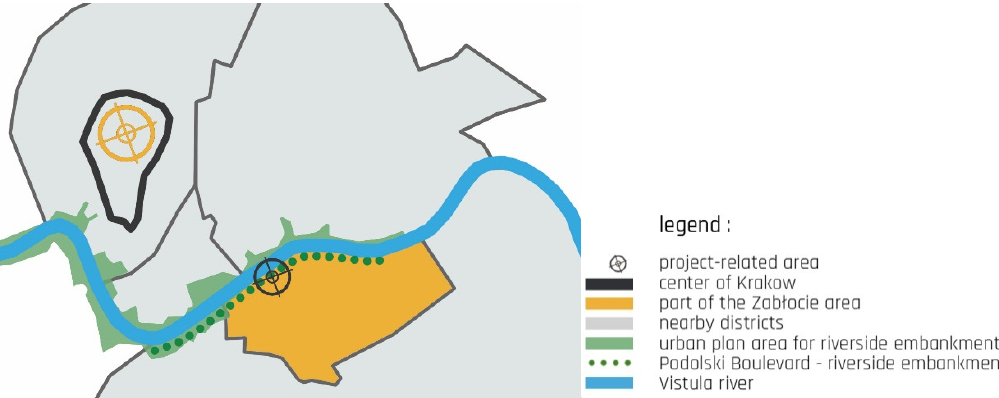
Figure 5. Boulevard of the Allied Forces Pilots (Bulwar Lotników Alianckich) within Podolski Boulevard (Bulwar Podolski) only partially covered by the Local Plan of Spatial Development of the area called ‘Vistula Boulevards’ (‘Bulwary Wisły’) [20], (elaborated by E. Latusek).